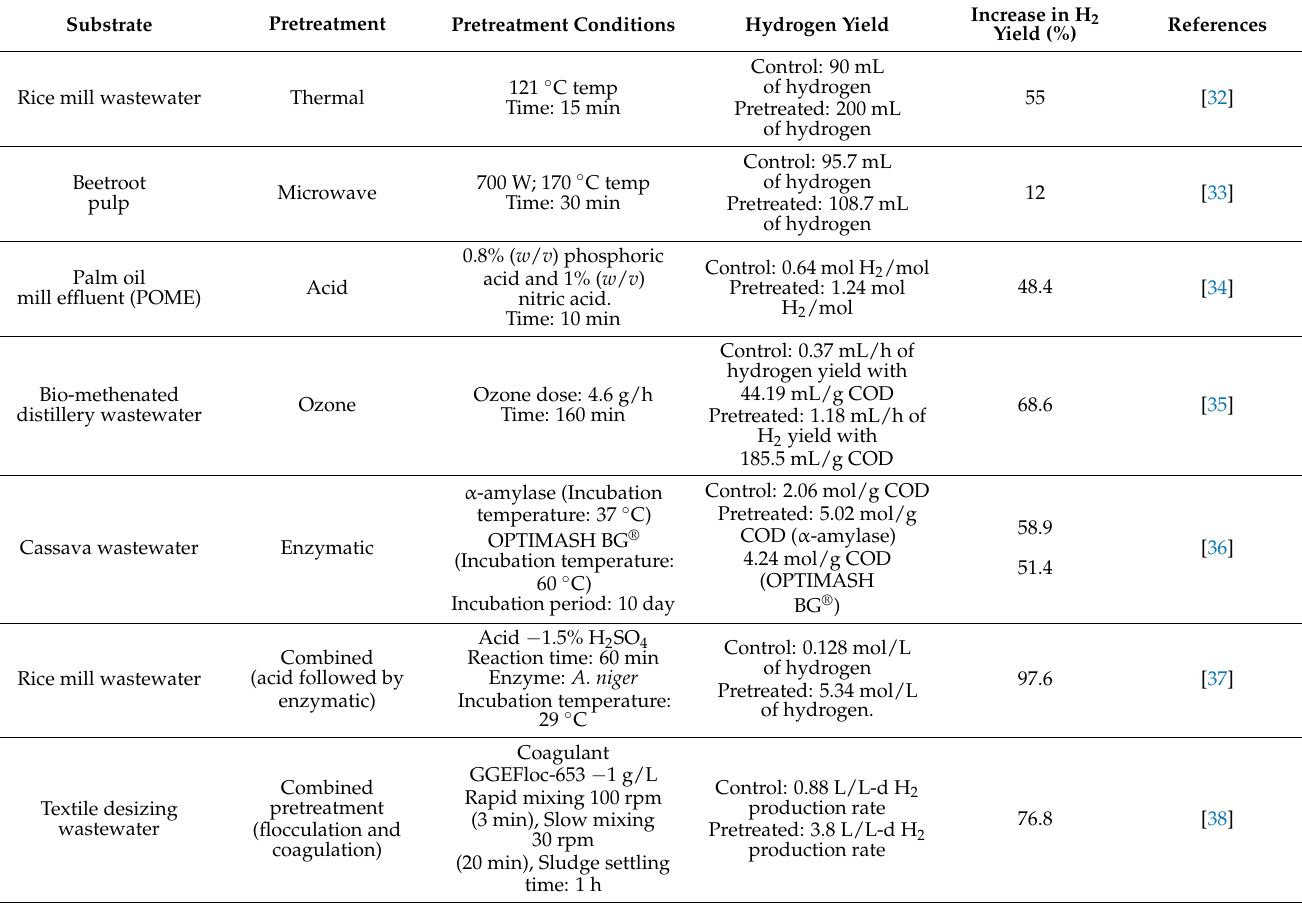
Table 2. List of various substrate pretreatment methods used for biohydrogen